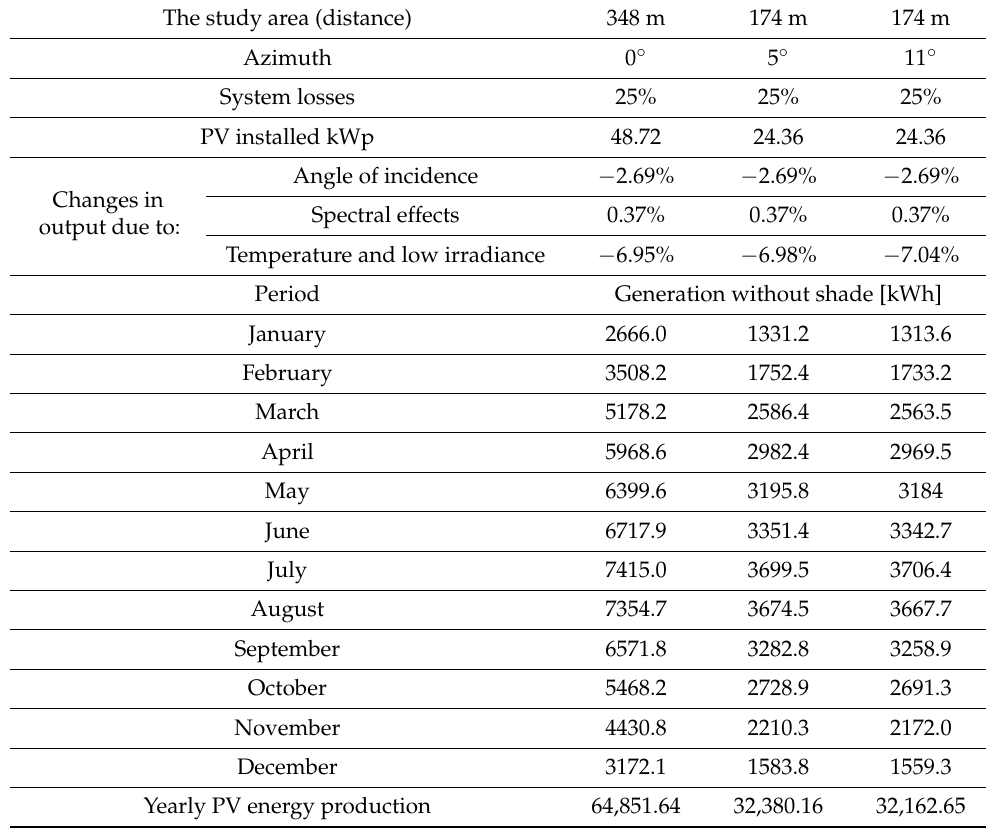
Table 6. Shadowless generation.